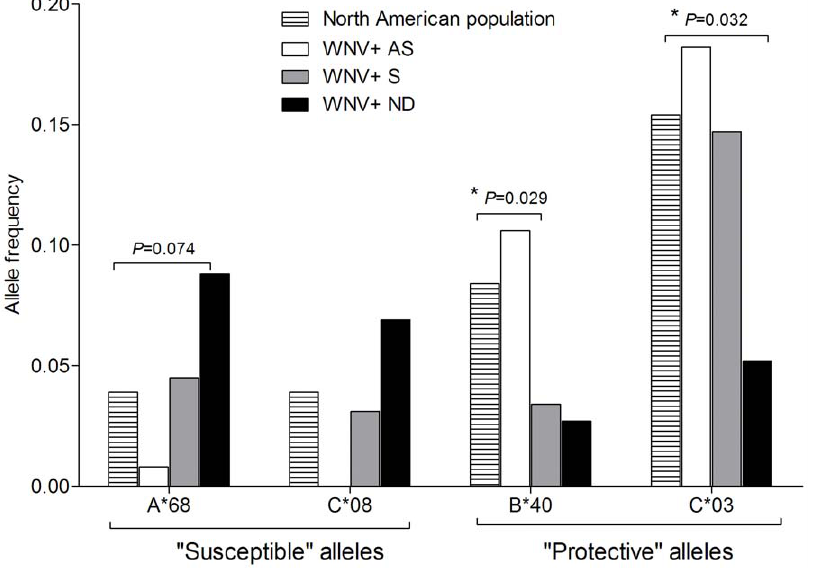
Figure 2. ‘‘Susceptible’’ and ‘‘protective’’ alleles in the North American population and in the WNV + cohort. The histogram displays the allele frequency of each ‘‘susceptible’’ and ‘‘protective’’ allele in the North American population and in the asymptomatic (AS), symptomatic (S), and having neuroinvasive disease (ND) WNV + individuals. * P , 0.05.